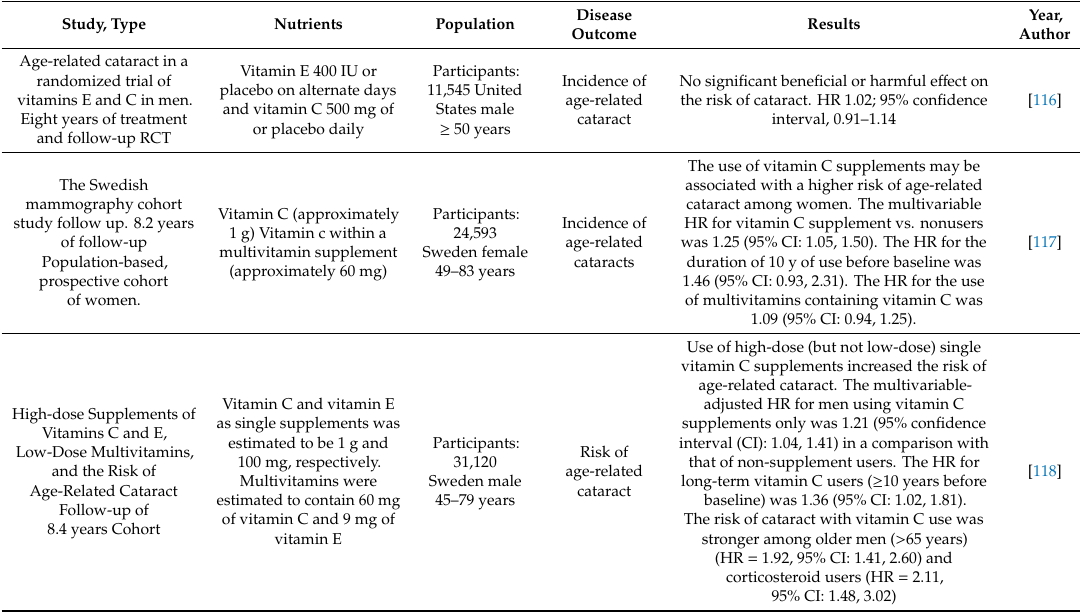
Table 2. Human studies investigating the e ff ect of vitamin C supplements on the development of